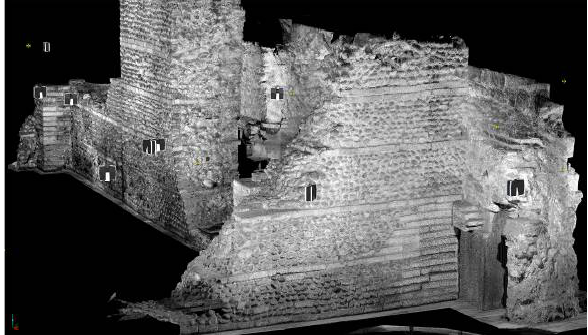
Figure 7. The complete point cloud of the archaeological site in via del Lauro